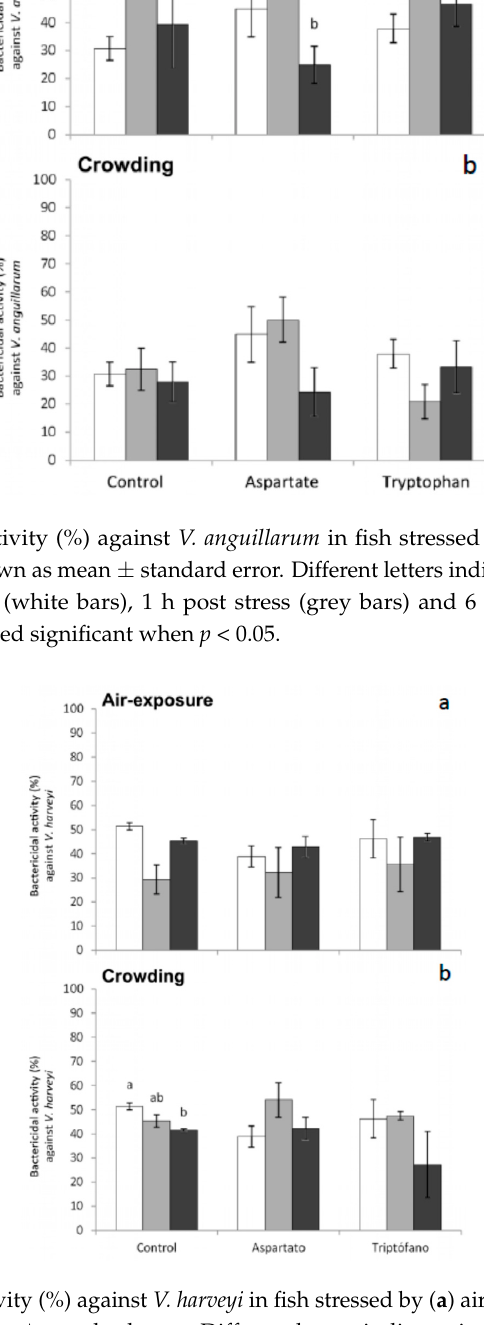
Figure 6. Bactericidal activity (%) against V. harveyi in fish stressed by ( a ) air-exposure or ( b ) crowding. Results are shown as mean ± standard error. Different letters indicate significant differences among non-stressed fish (white bars), 1 h post stress (grey bars) and 6 h post stress (black bars). Differences were considered significant when p <